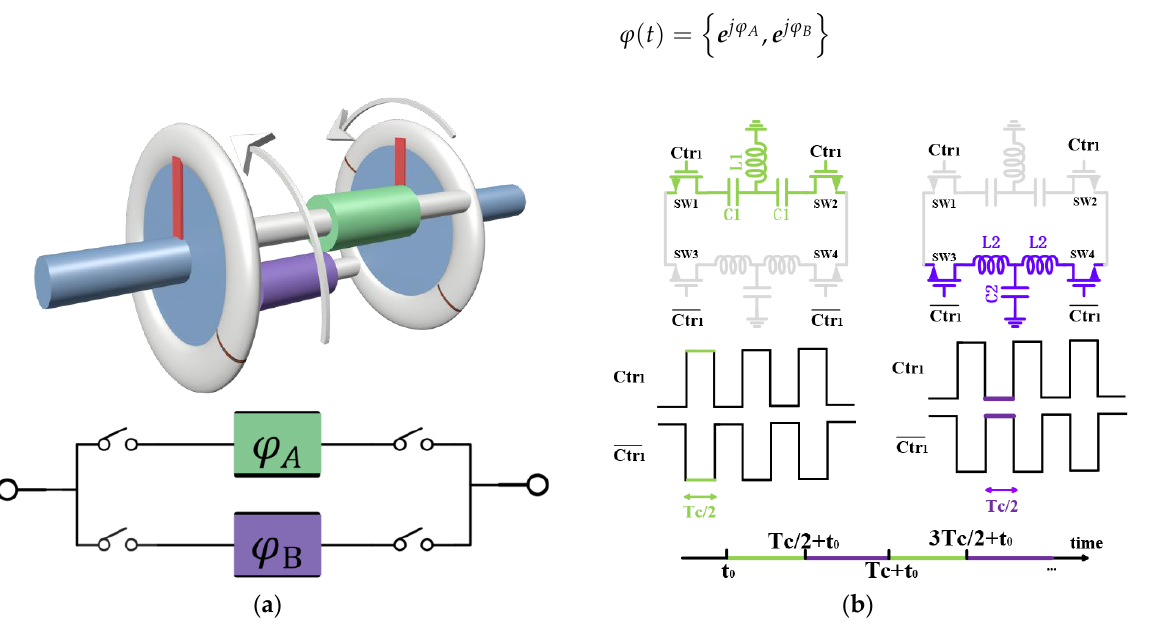
Figure 2. Structure of the proposed TVPM. ( a ) The diagram of the proposed TVPM. ( b ) Circuit realization method and key parameters of the proposed TVPM.